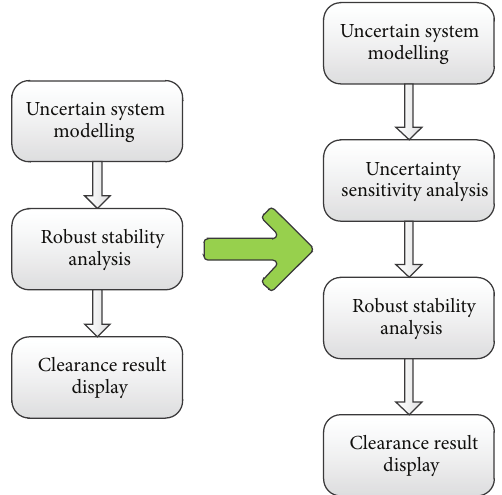
Figure 1: The new clearance